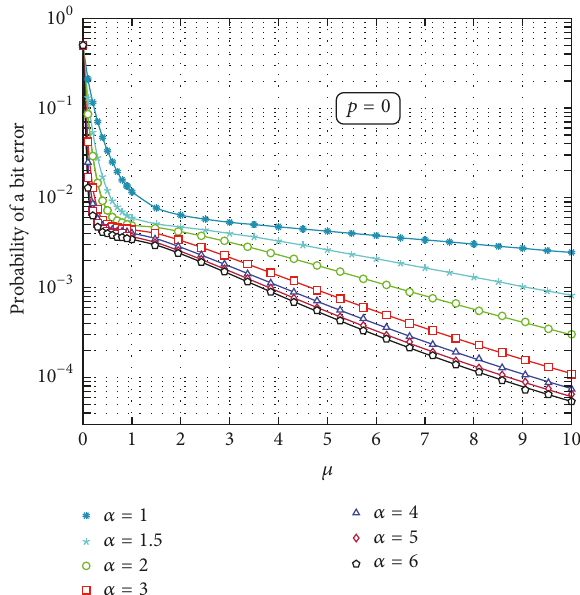
Figure 5: Average BER against the fading parameter 𝜇 under 𝛼 - 𝜇 fading channel with SNR = 20 dB, 𝐿 = 3 , and 𝑝 = 0